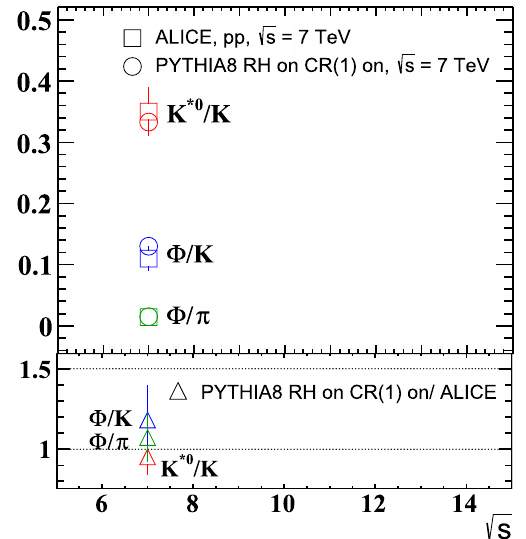
Fig. 6 The p T -integrated ratio as a function of charged particle mul- tiplicity in proton–proton collisions at 7 TeV [5]